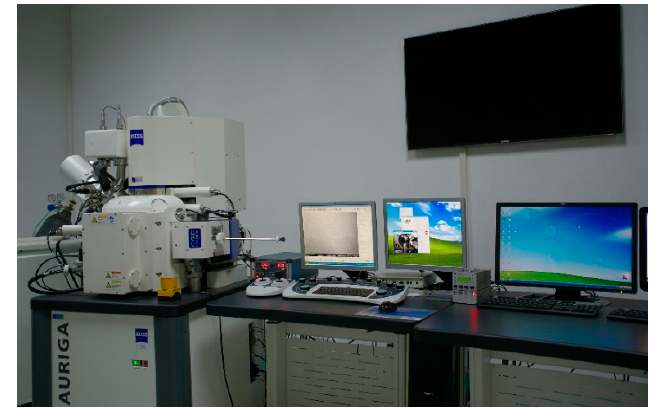
Figure 4. The auto-compensated and auto-equilibrated triaxle cell system.